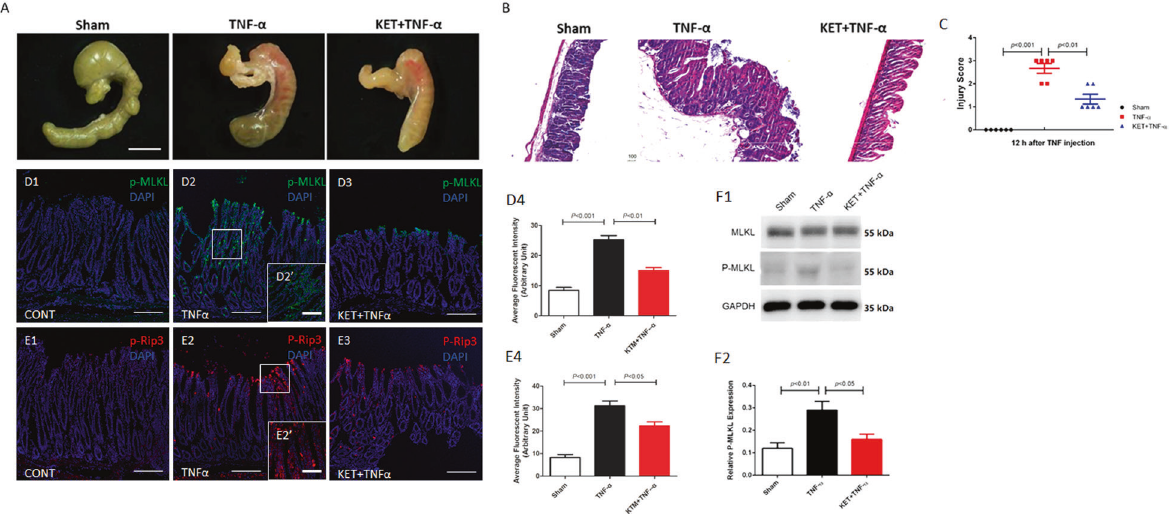
Fig. 3 Ketamine protected mice from TNF - α -induced cecal damage by suppressing the phosphorylation of RIP3 and MLKL. A Representative images of cecal tissue from mice in each group at 12 h after the injection of 15 μ g of TNF- α . B When a mouse became moribund, tissues were collected, sectioned, and stained with H&E. Representative images are shown. Scale bar, 100 μ m. TNF-induced cecal damage at the indicated time was scored and is shown in C . D , E Immuno fl uorescent staining and statistical analysis of the expression of the necroptosis markers p-MLKL and p-RIP3 in cecal tissue from mice in each group at 12 h after the injection pf 15 μ g of TNF- α . F Western blot analysis of the expression of the necroptosis markers MLKL, p-MLKL in cecal tissue from mice in each group at 12 h after the injection pf 15 μ g of TNF- α . All data are shown as the mean ± SEM. n =